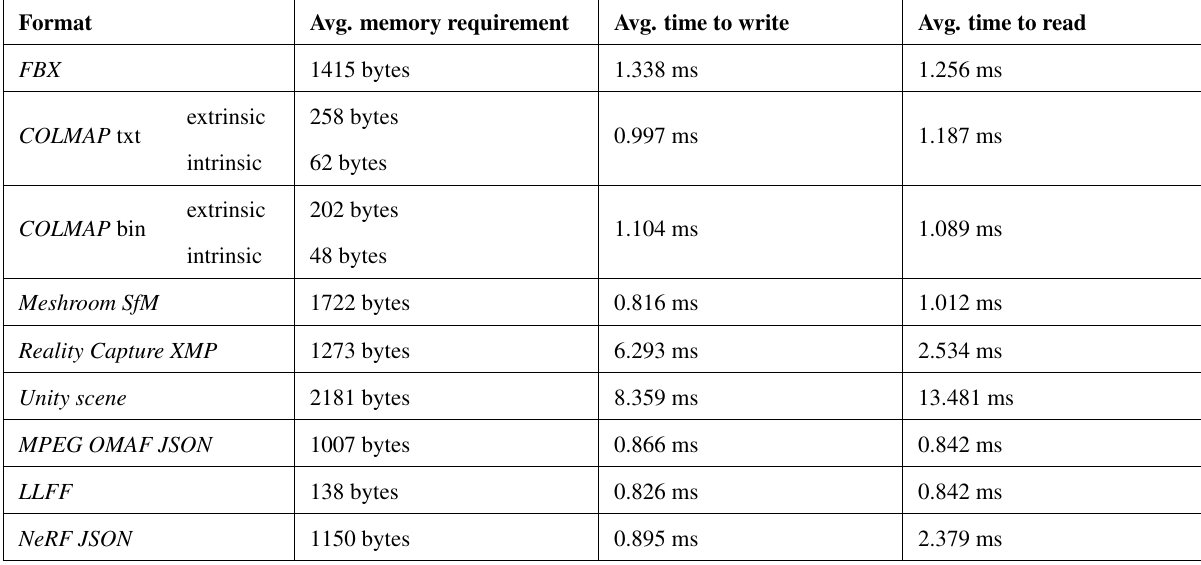
Table 2. Memory requirement and time complexity of different formats. The values are given for one